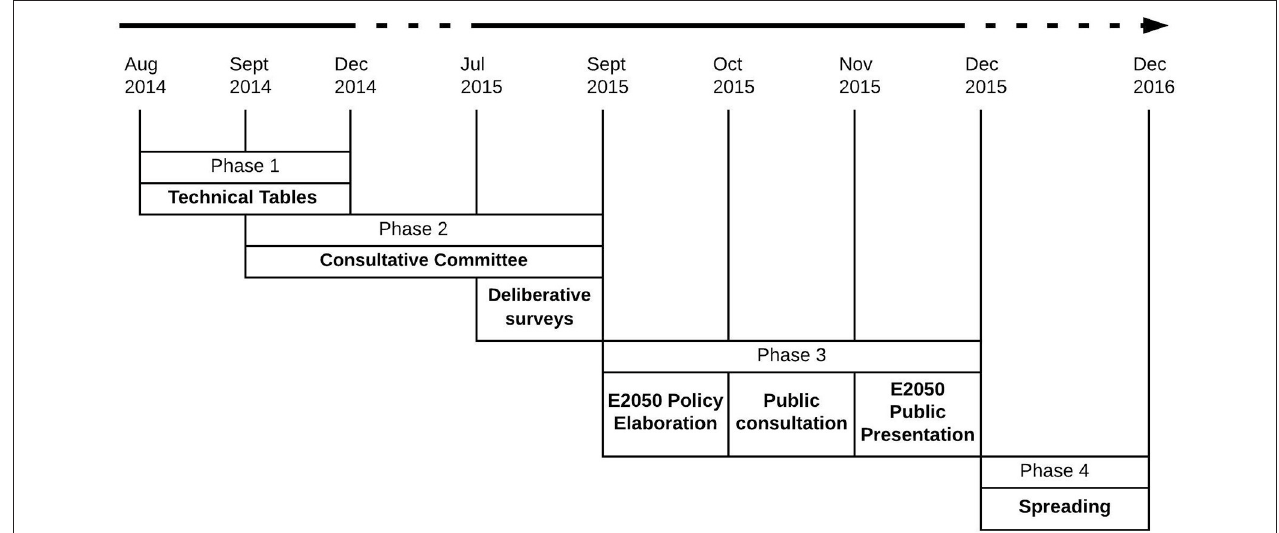
FIGURE 3 | E2050 construction